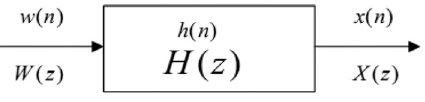
Fig. 2. Parametric model of stochastic